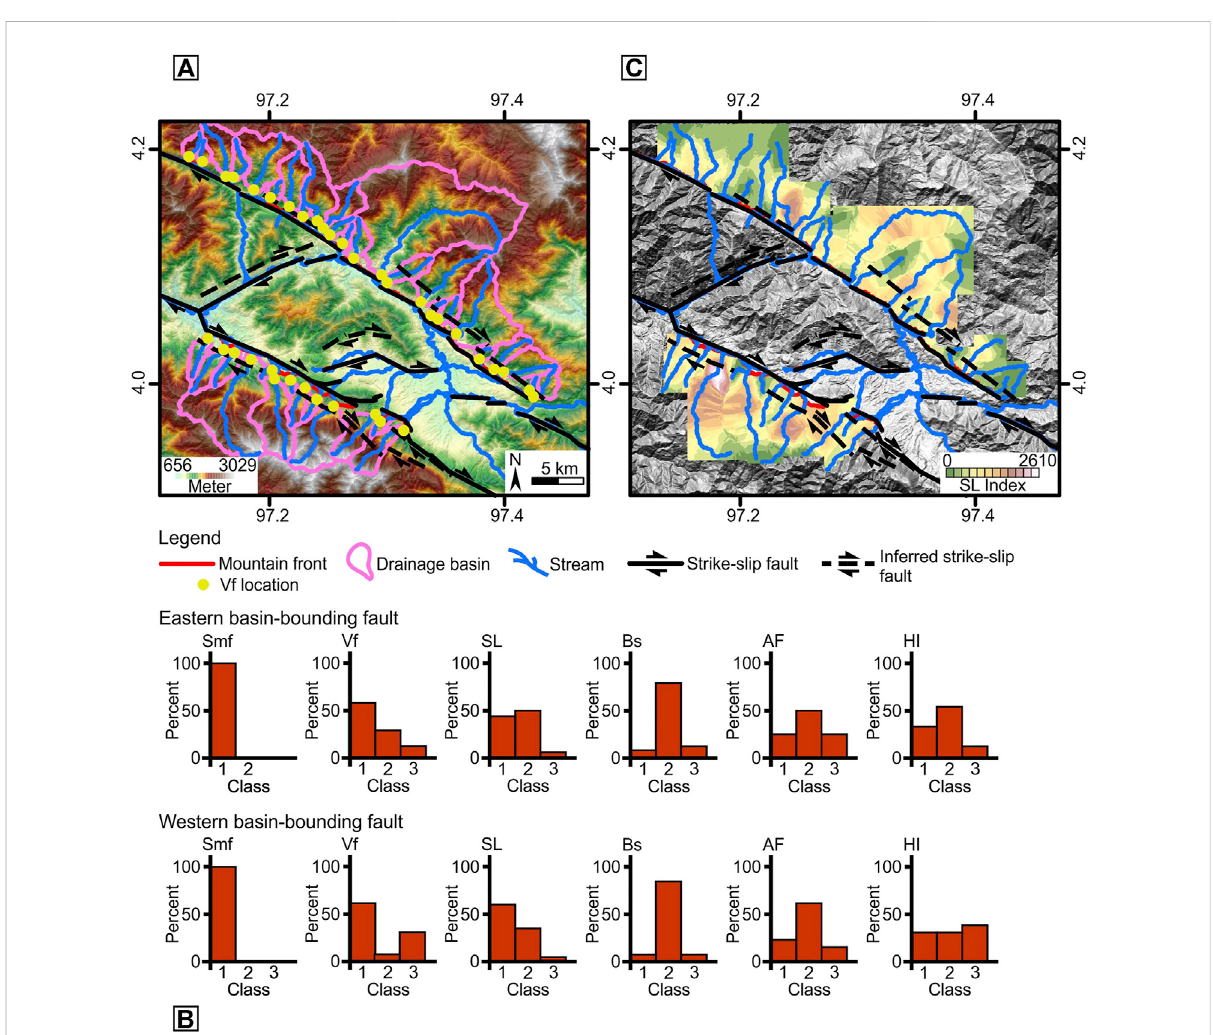
FIGURE 11 The Blangkejeren Basin: (A) the mountain fronts, faults, and drainage basins, (B) classi fi cation of geomorphic indices, and (C) stream length- gradient